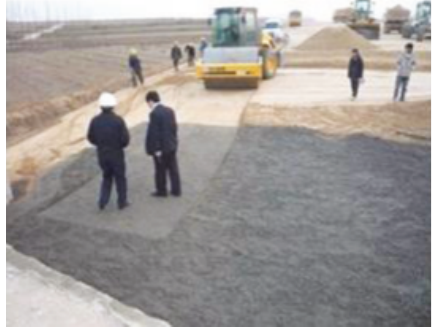
Figure 17: Material abandoning.